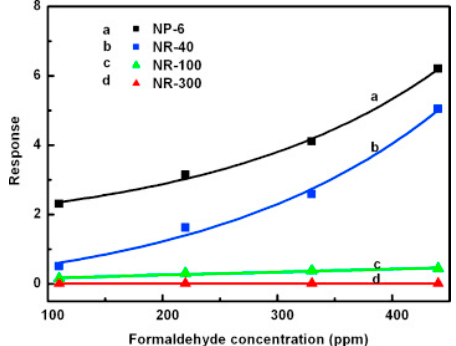
Figure 31. Responses of the NP-6, NR-40, NR-100, and NR-300 samples towards formaldehyde without UV light irradiation. Reproduced with permission from [13].